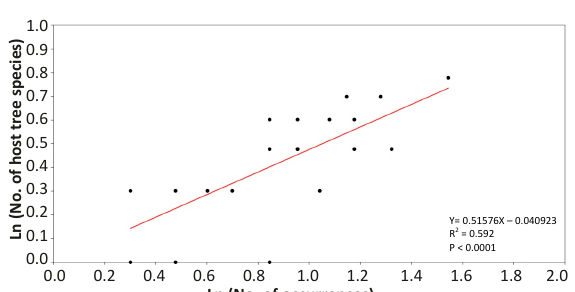
Figure 2. Increase in number of polypore fungi in moist deciduous forests of Peechi-Vazhani Wildlife Sanctuary with increase in number of host trees